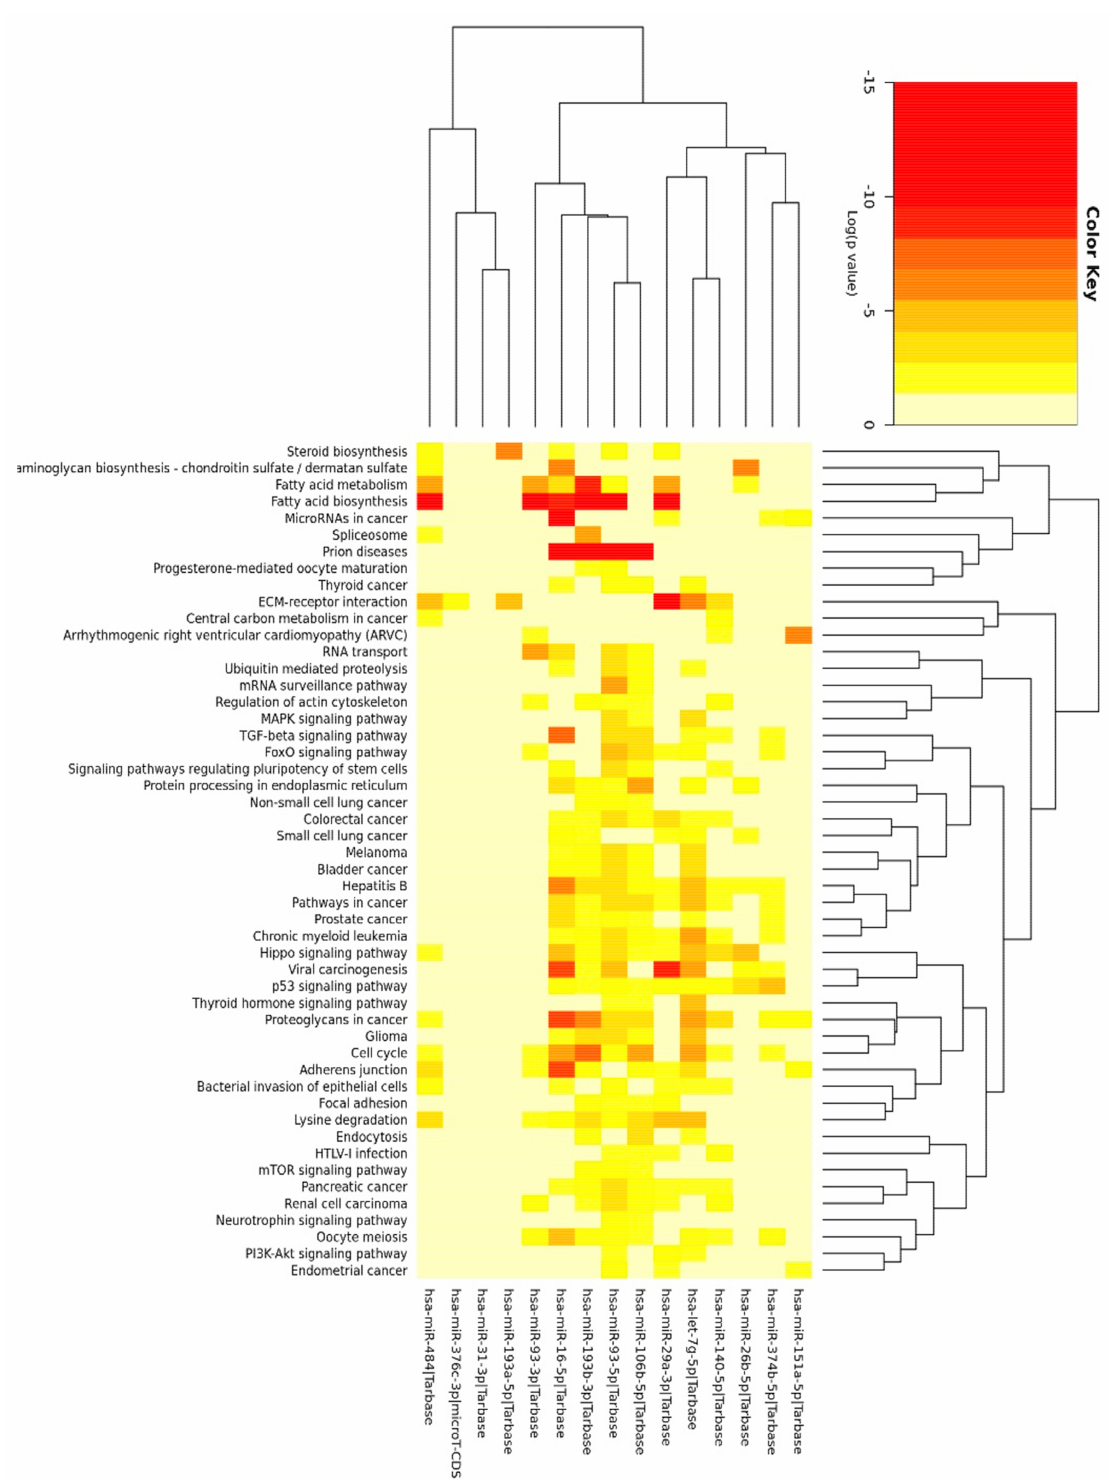
Figure 6. The heat map of results generated by DIANA-miRPath v3.0 and merged by pathways’ union for 15 core miRNAs (significance clusters). Full name of the second record is “Glycosaminoglycan biosynthesis: chondroitin sulfate / dermatan